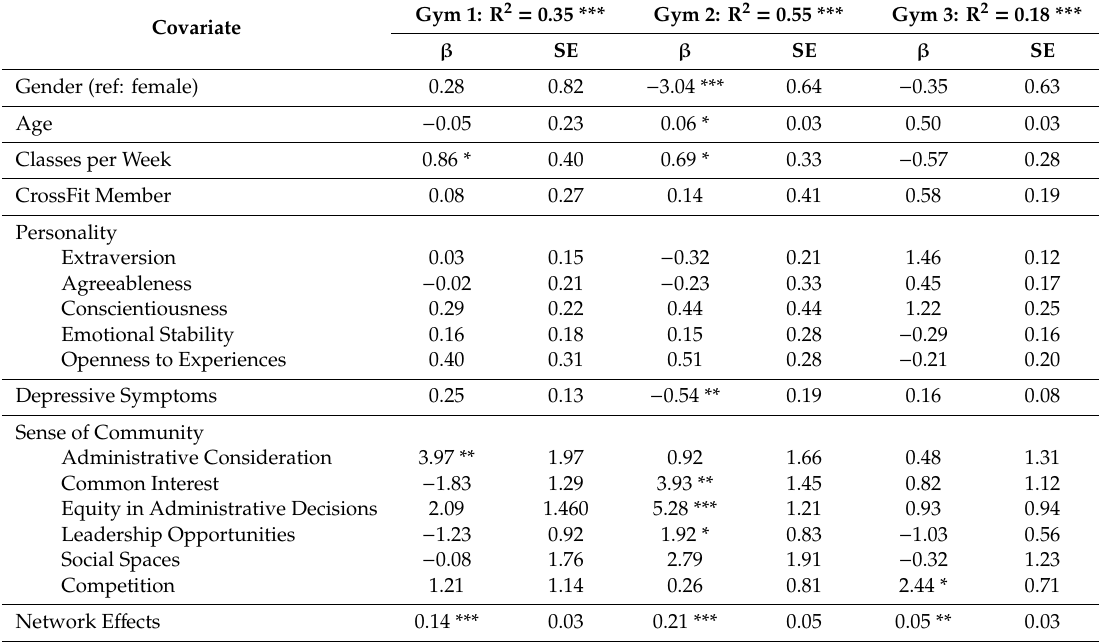
Table 2. Linear network autocorrelation models assessing preference scores in three CrossFit